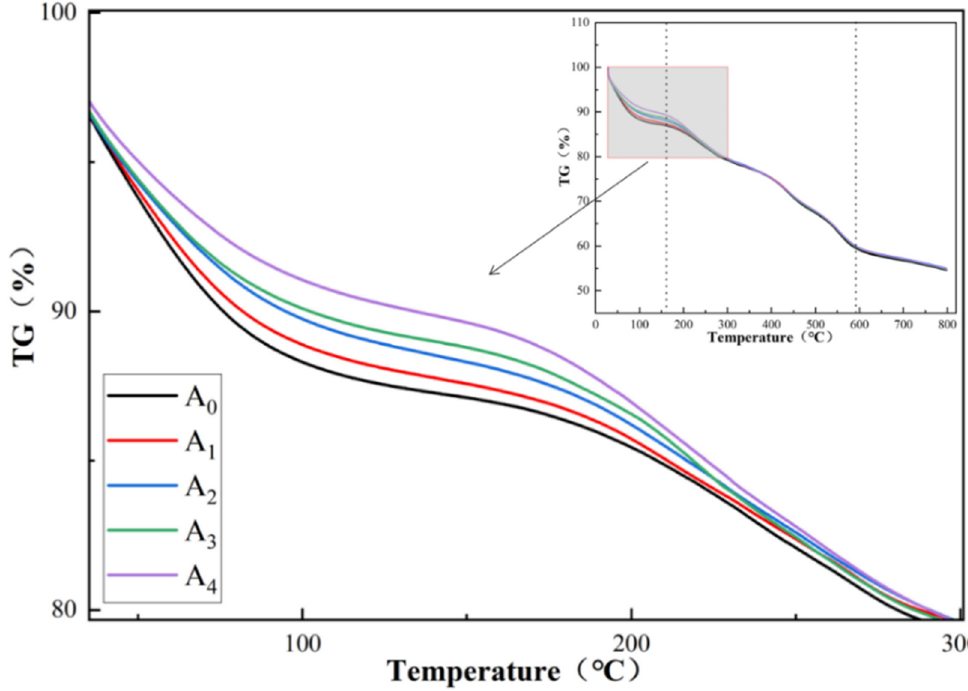
Figure 7. Thermogravimetric analyzer (TGA) profile recorded for the UiO − 66 − NH 2 system synthe- sized under conditions of varying silver doping levels.